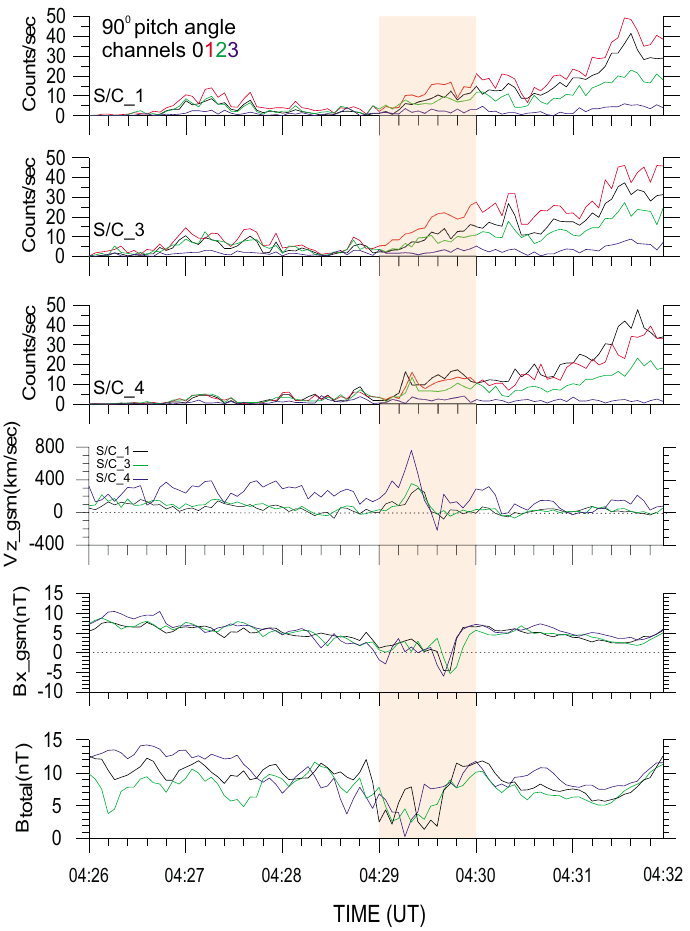
Fig. 7. 4-s time resolution measurements of energetic electron count rates for the first four energy channels and for a 90deg pitch angle during the beginning of the event. Also shown are the V z plasma moment, the B x magnetic field component and the B total magnetic field